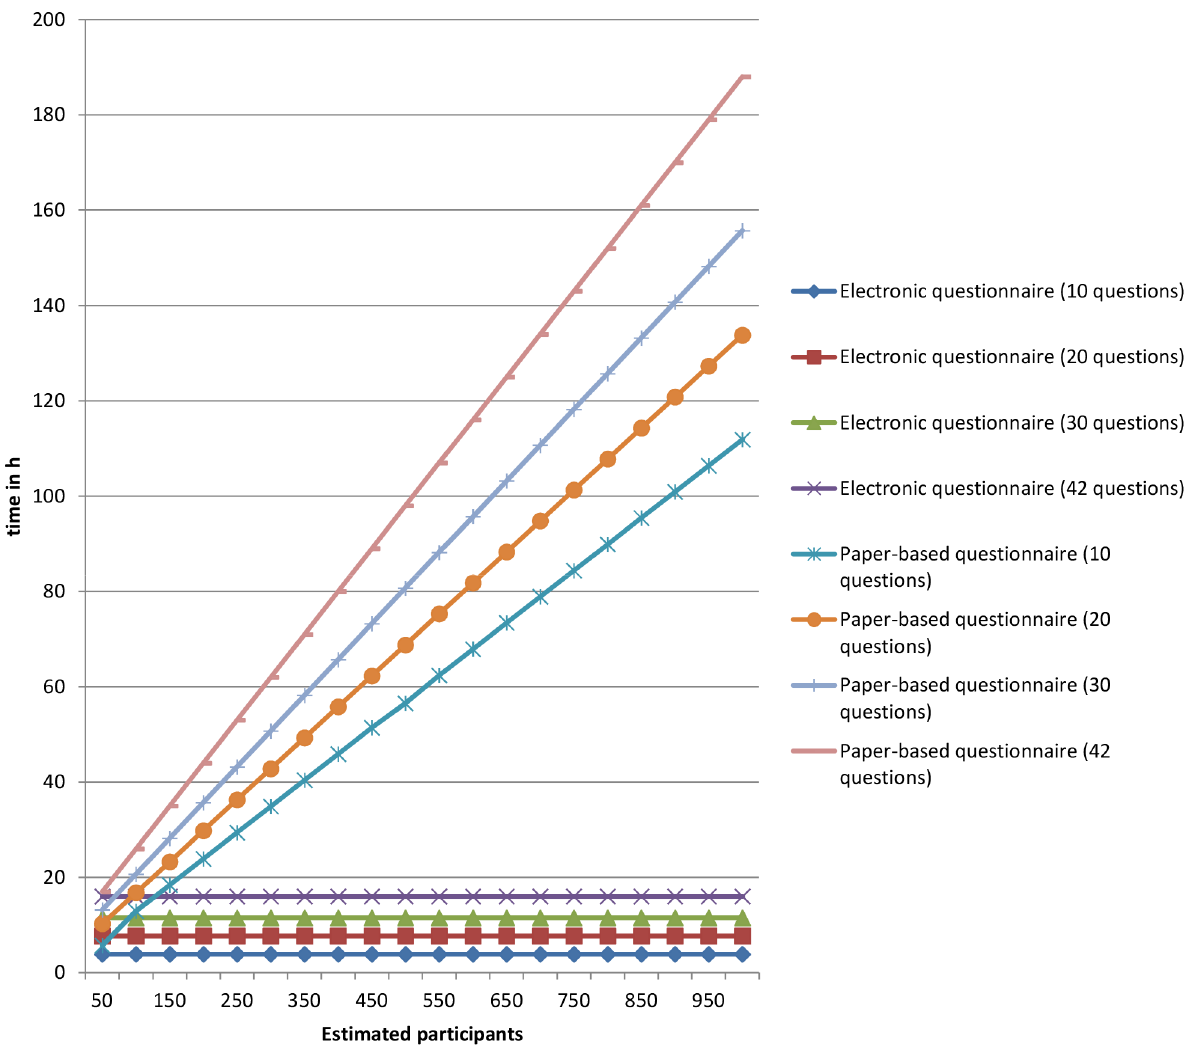
Figure 2. Estimated time required for electronic and paper-based surveys with different cohort sizes and numbers of questions based on the surveys E 1 (centralized e-mails), H 1 (homepage link), and P 1 (paper-based questionnaires).